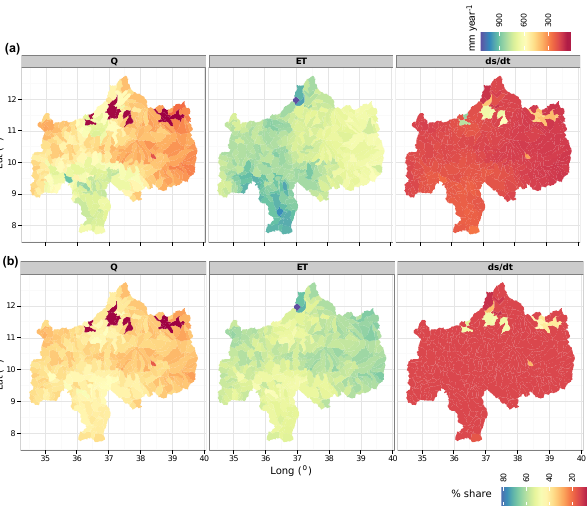
Figure 8. The spatial distributions of long-term mean annual water- budget closure: precipitation in millimeters (Fig. 3), the output terms ( Q , ET, d s / d t ) in millimeters (a) , and the percentage share of the output term ( Q , ET, d s / d t ) of the total precipitation (b) .